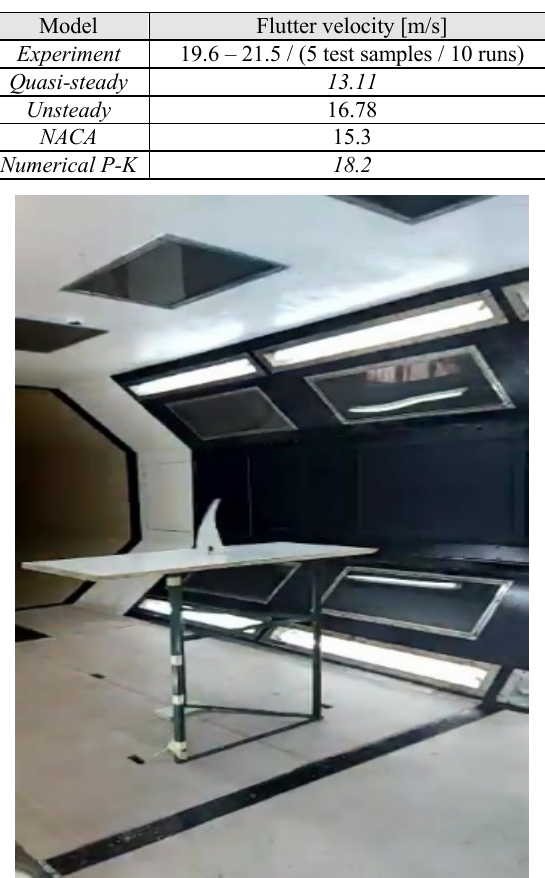
Figure 16. Wind tunnel flutter